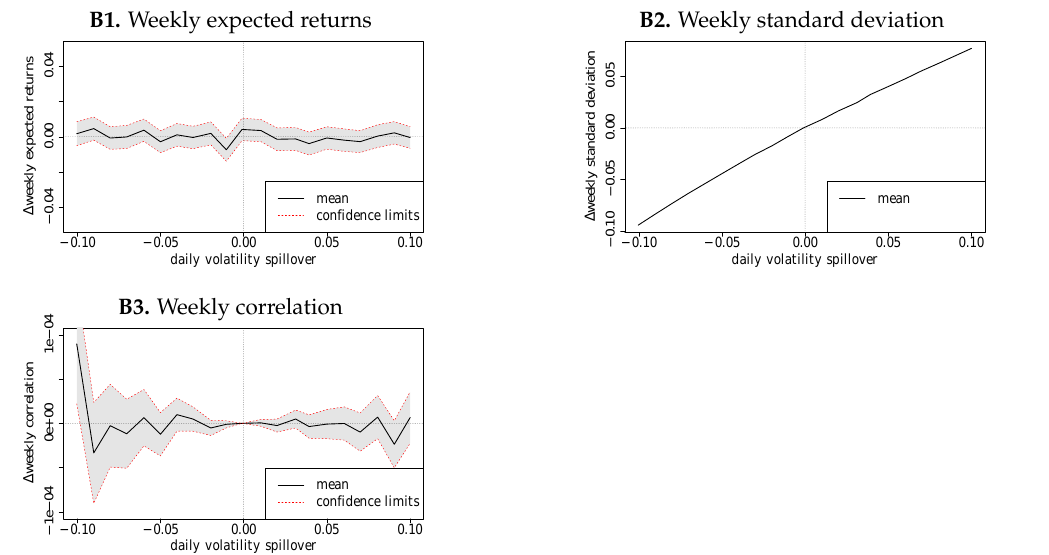
Figure 7. Effects of volatility spillovers on assets’ characteristics. This figure presents the effects of daily volatility spillovers on the spillover-receiving asset’s characteristics including expected returns, standard deviation and its correlation with the spillover-giving asset at daily frequency ( A ) and weekly frequency ( B ). We use “daily” and “weekly” for the illustration purpose; the results also apply to other relative “high” and “low” frequencies. Because of overlaps between lines, for brevity we only present results for a = 0. The results for a = − 0.5 and a = 0.5 are qualitatively